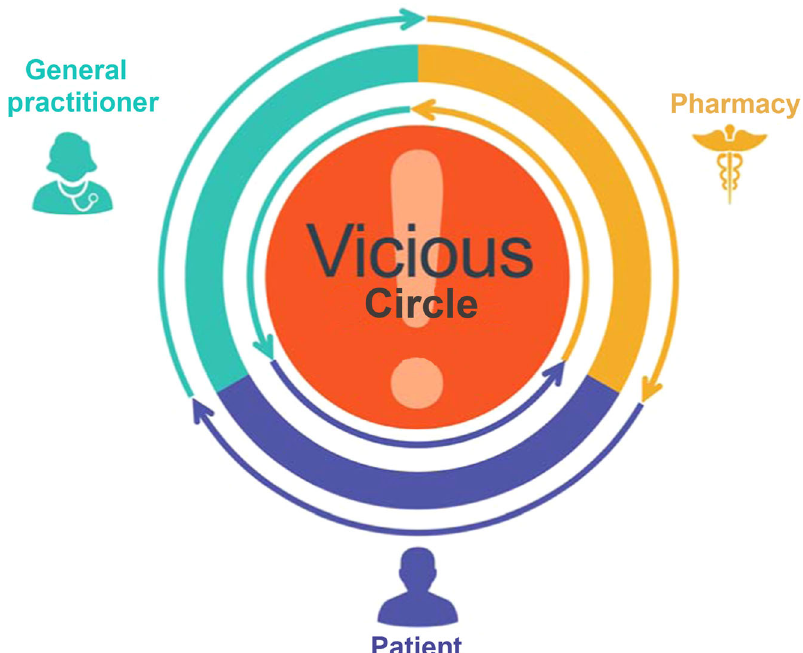
Fig. 1 Vicious circle of care. Many patients with asthma are stuck in a vicious circle of misdiagnosis, inadequate treatment and poor understanding of disease severity and